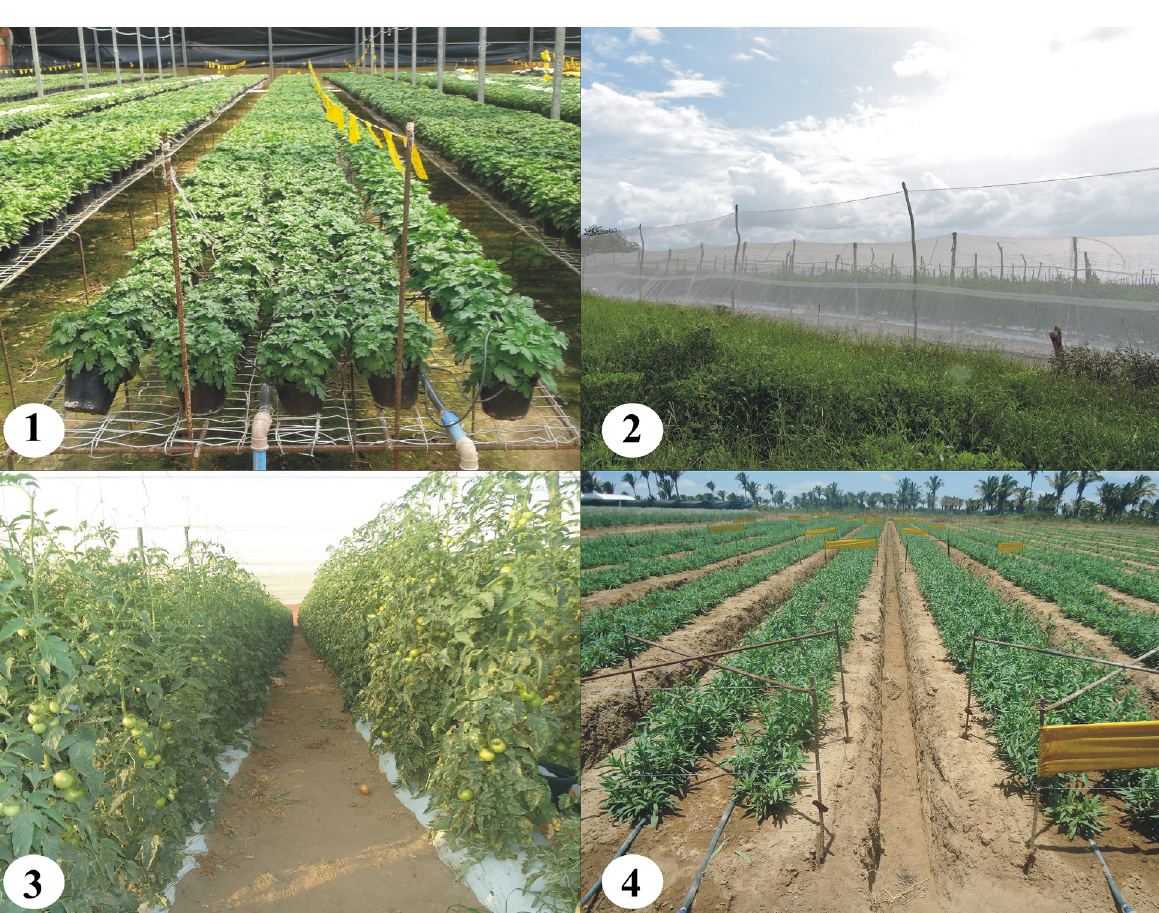
Figure 1 - ( 1 ) Image of Chrysanthemum morifolium Ramat. greenhouses; ( 2 ) Image of Solanum lycopersicum L. protected crop, external overview of the culture; ( 3 ) Image of Solanum lycopersicum L. protected crop, internal view of the culture; ( 4 ) Image of Gypsophila paniculata L. open